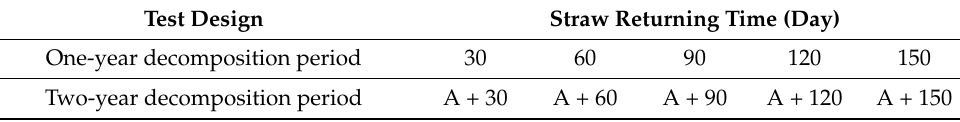
Table 2. Sampling